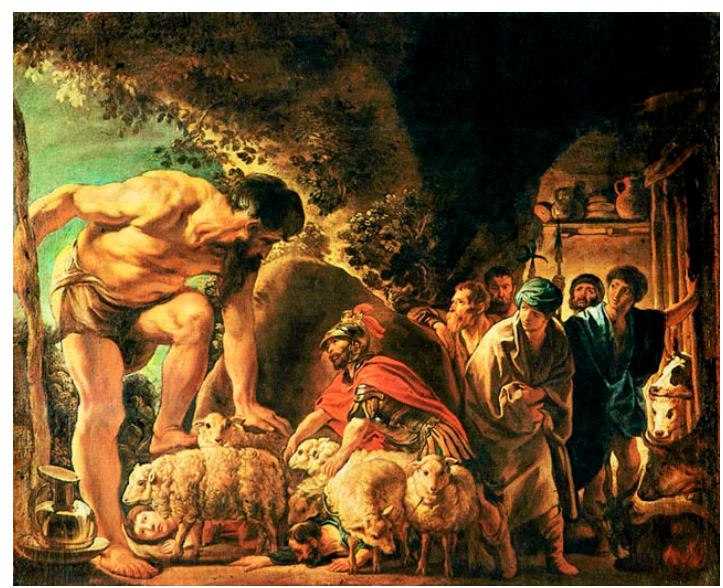
Figure 3. Odysseus in the Cave of Polyphemus: Jacob Jordaens, 1635.